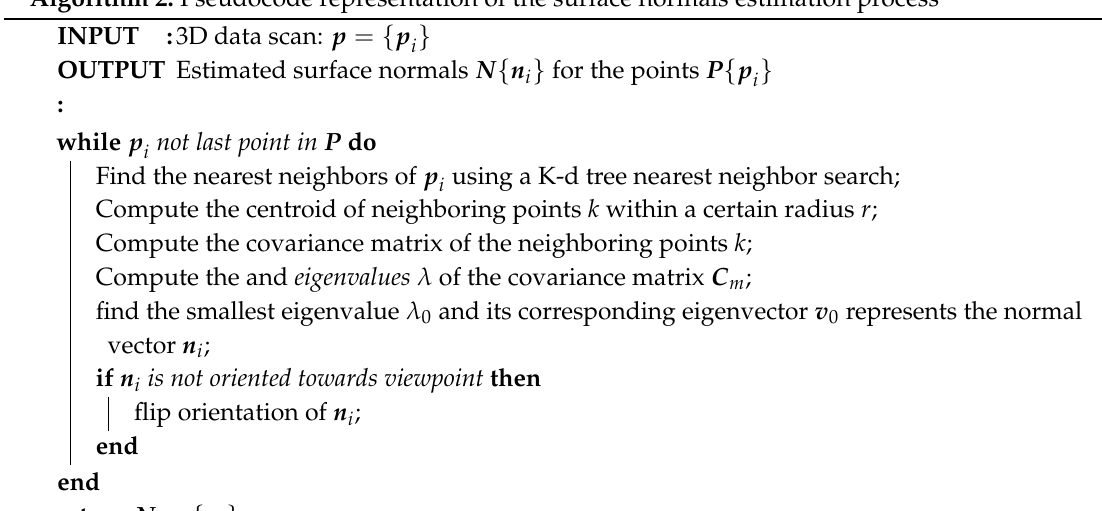
Figure 5. Local minima escape, computation of surface normals, and two-step local minima escape. Algorithm 2: Pseudocode representation of the surface normals estimation